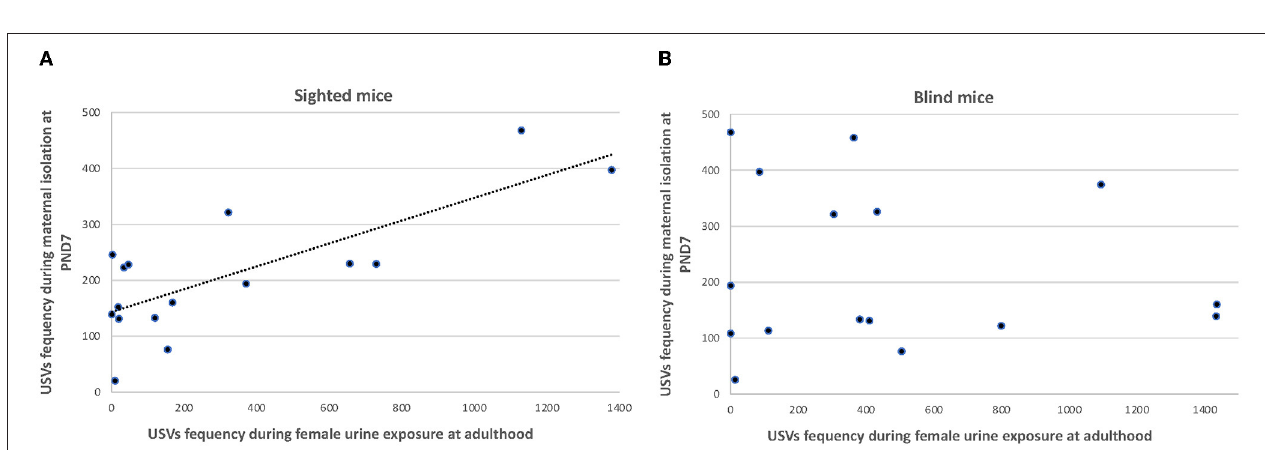
FIGURE 7 | Correlation graph of the total number of USVs emitted by PND 7 pups during the first 5-min isolation and during the scent-marking test in male adults (A) [sighted mice: r(16) = 0.599, p = 0.014], and (B) blind mice.